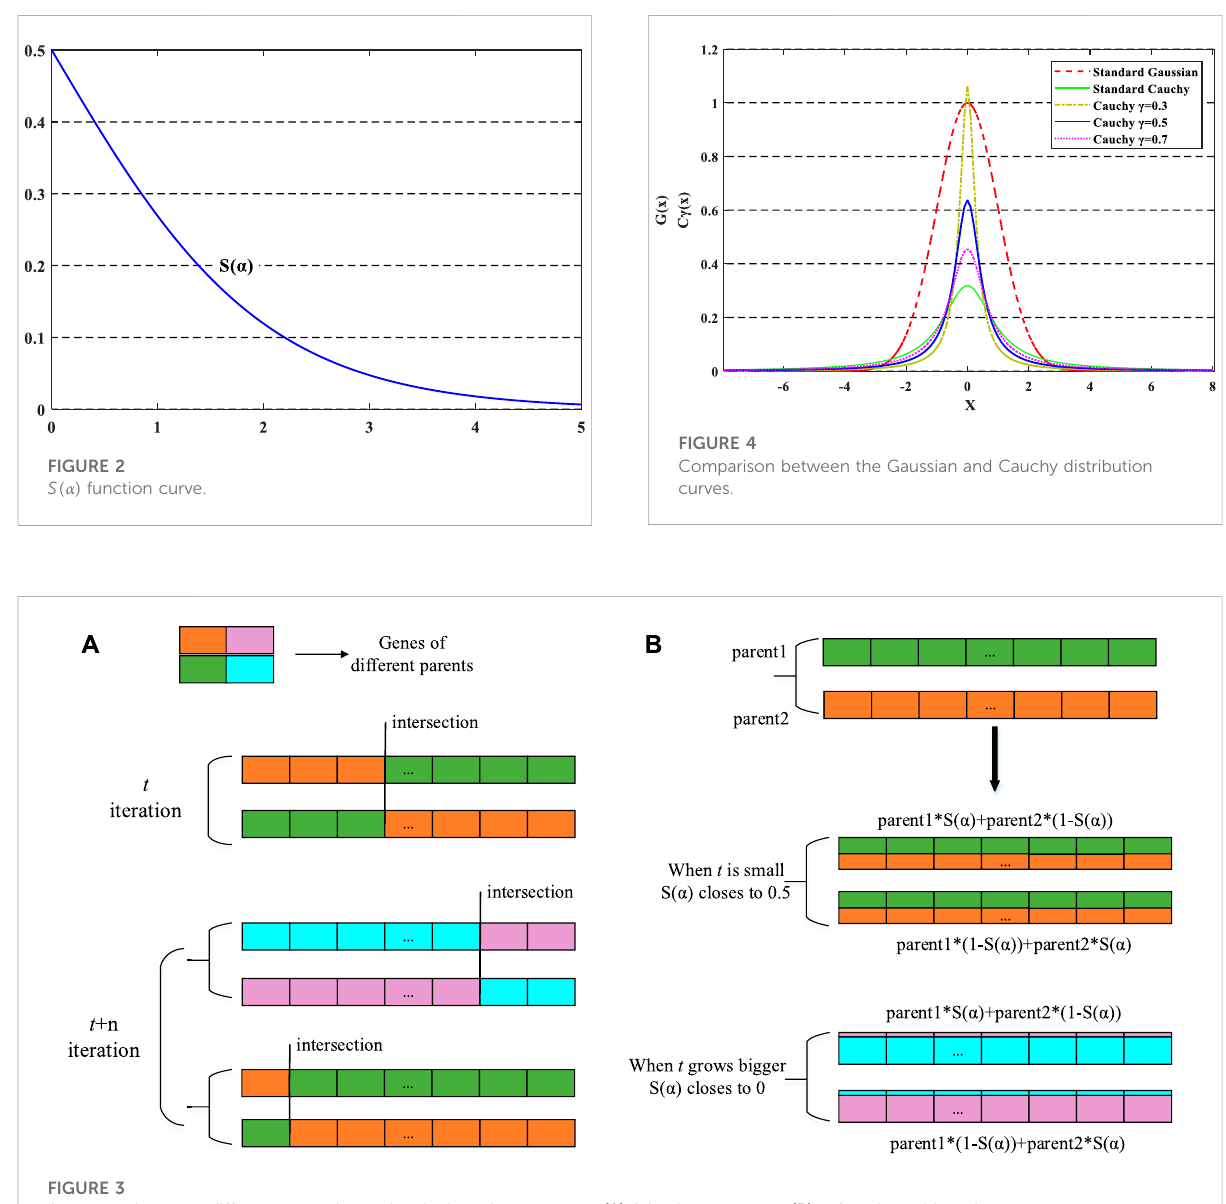
FIGURE 3 A contrast between different strategies under single-point crossover: (A) Adaptive crossover, (B) α -function arithmetic crossover.